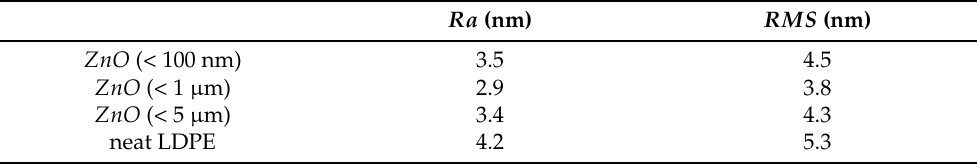
Table 4. Roughness values of ZnO composite films and neat